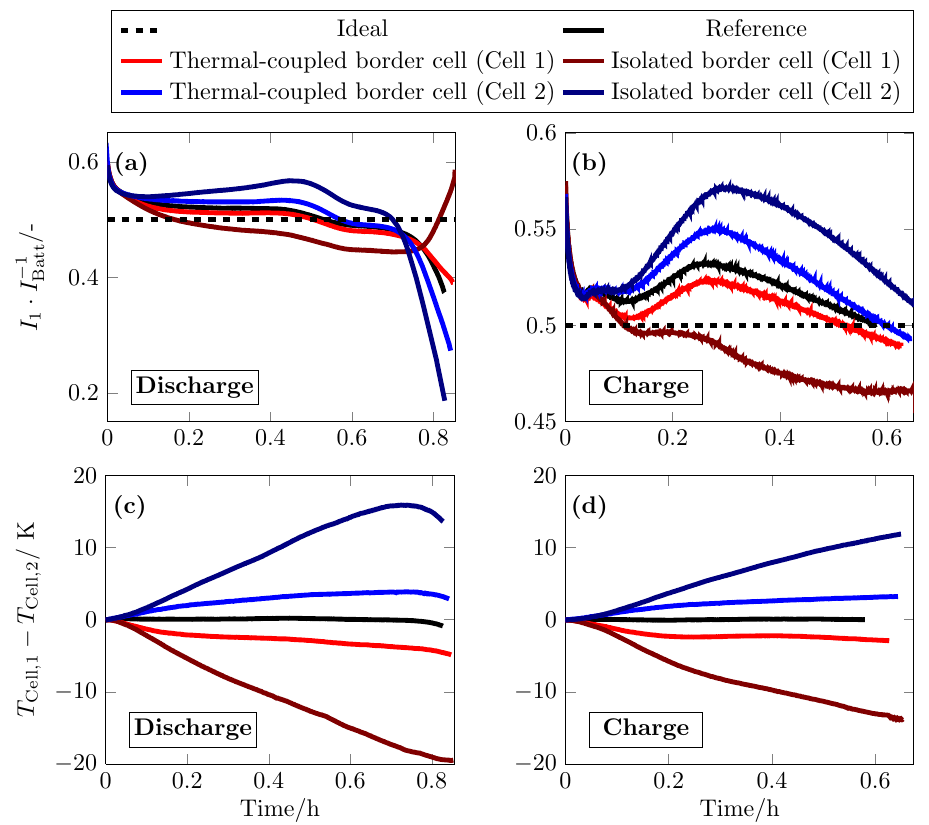
Figure 10. Measurements simulating different cell positions in a battery and thermal connections of cells to their neighbor cells of two parallel-connected cells. With the current ( a ) and temperature distribution ( c ) at discharge with I Batt = 1C as well as the current ( b ) and temperature distribution ( d ) at charge with I Batt =